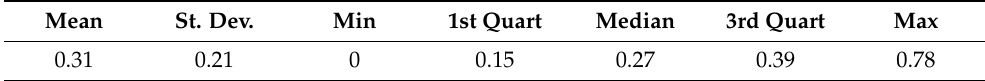
Table 3. The descriptive statistics of the gender policies items categories’